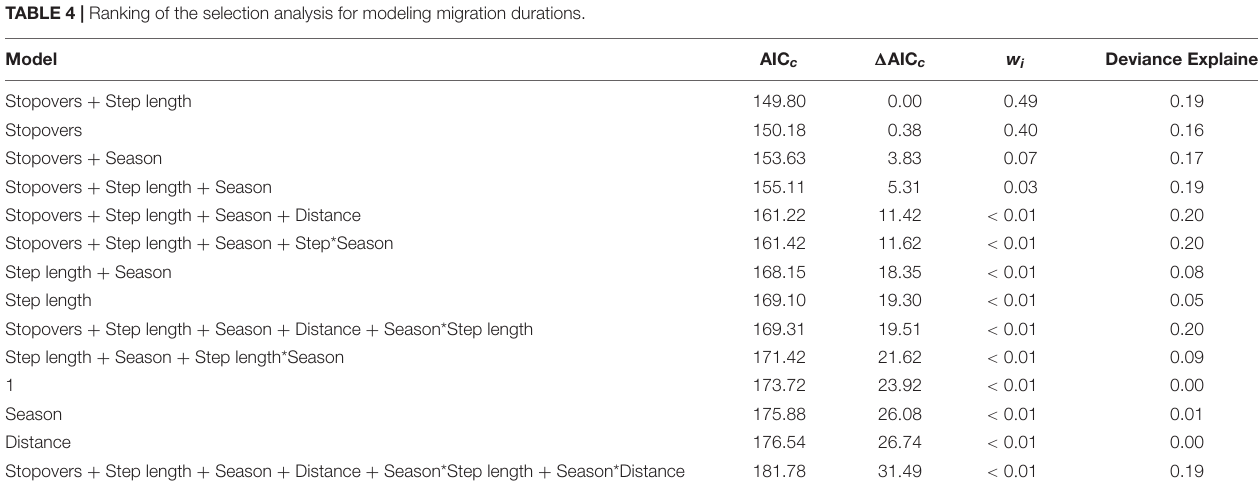
FIGURE 5 | The effects of number of stopovers (A) , step length (B) , and season (C) on duration of manatee migrations. TABLE 4 | Ranking of the selection analysis for modeling migration